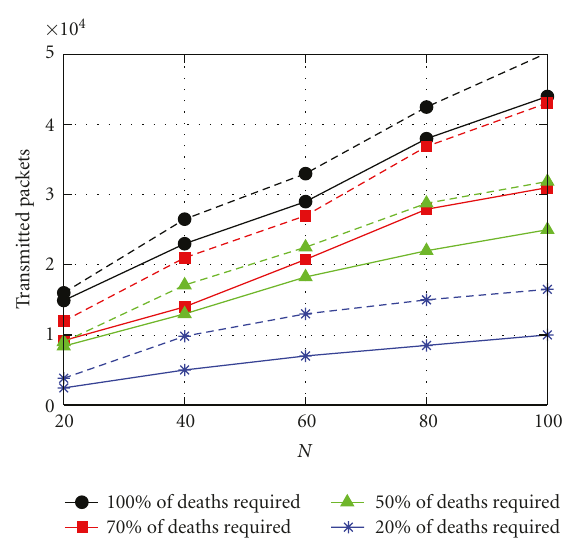
Figure 15: Number of transmitted packets, as a function of the number of sensors N , in a ZigBee wireless sensor network with nodes’ failures. Two possible distributions for a single sensor life- time are considered: (a) exponential with μ = 300 seconds (solid lines) and (b) uniform with t max = 600 seconds (dashed lines).